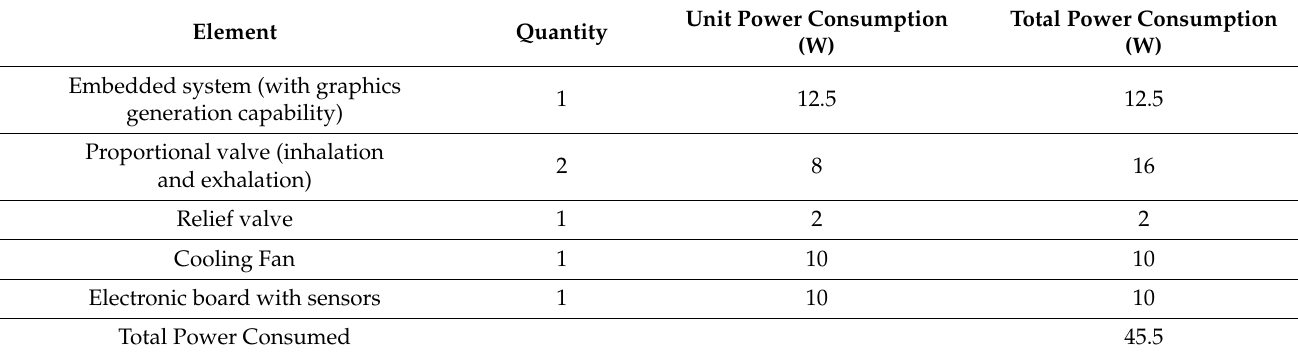
Table 2. Electrical elements’ power